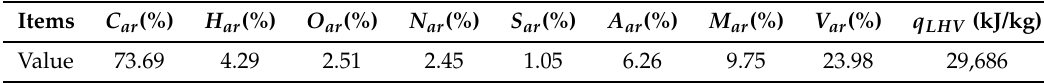
Table 3. Elemental analysis of the selected